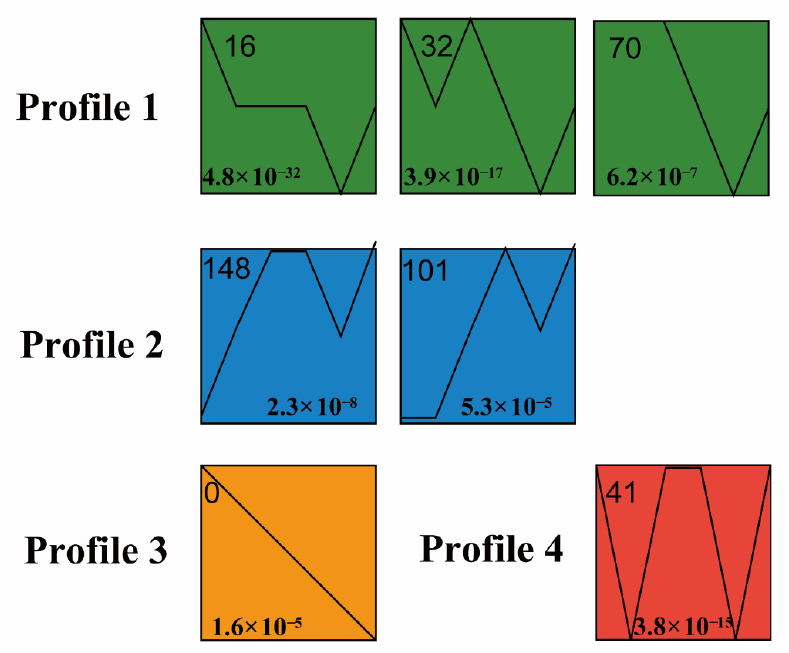
Figure 6. Seven main possible model profiles recognized by STEM. The Short Time‑Series Expression Miner (STEM) program classified the 307 TF genes into four main possible model profiles according to the temporal gene expression patterns, and within these recognized 7 significant patterns of gene expression ( p < 0.05). The broken line in the figure shows the trend of expression quantity changing with time, and the value at the lower left corner represents the corresponding significant level ( p − value).